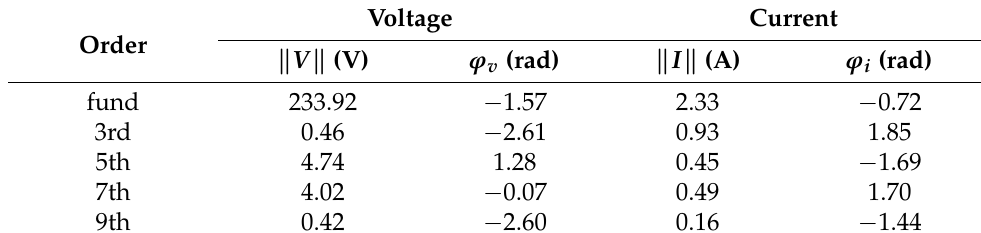
Table 3. Odd harmonics present in the waveforms of Example 2.